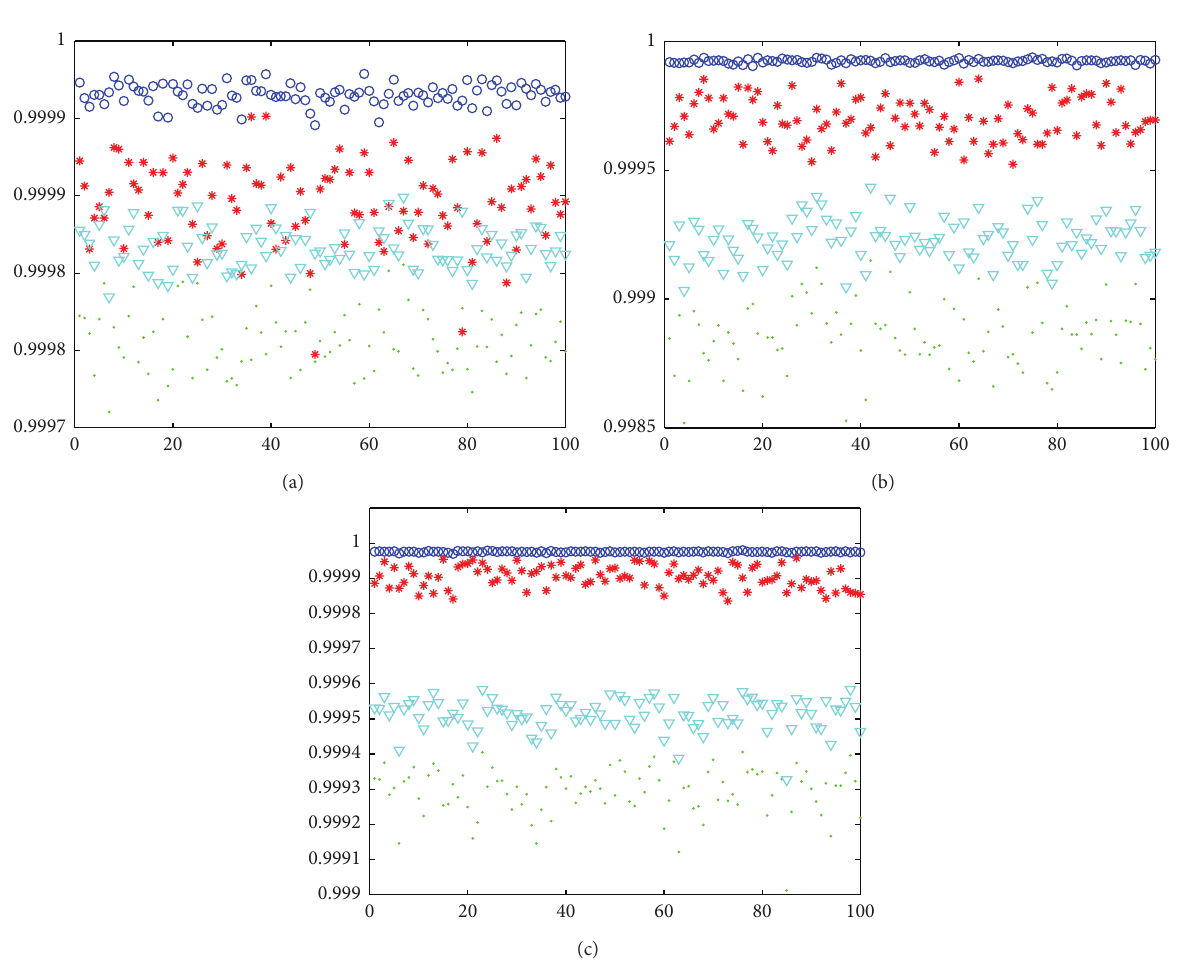
Figure 1: Spectral radius for random PSD matrices 𝐴 𝑇 𝐴 + diag ( rand (𝑛,1)) of size 𝑛 = 50 (a), 𝐴 𝑇 𝐴 + 10 ∗ diag ( rand (𝑛, 1)) of size 𝑛 = 50 (b) and 𝐴 𝑇 𝐴 + 30 ∗ diag ( rand (𝑛,1)) (c) of size 𝑛 = 150